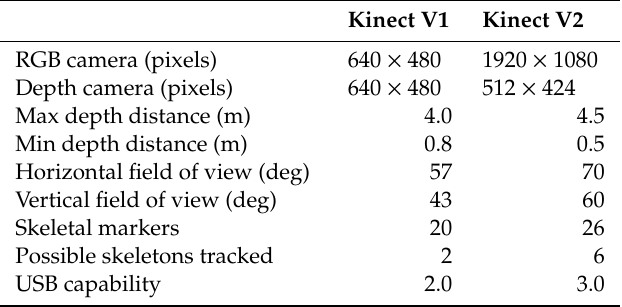
Table A1. Comparison of the first-generation Microsoft Kinect V1 (K1) and the second-generation Microsoft Kinect V2 (K2). The K2 boasts improved motion sensing hardware, particularly in resolution, field of view, and sensing algorithms. This is adapted from Pagliari and Pinto (2015) [25].